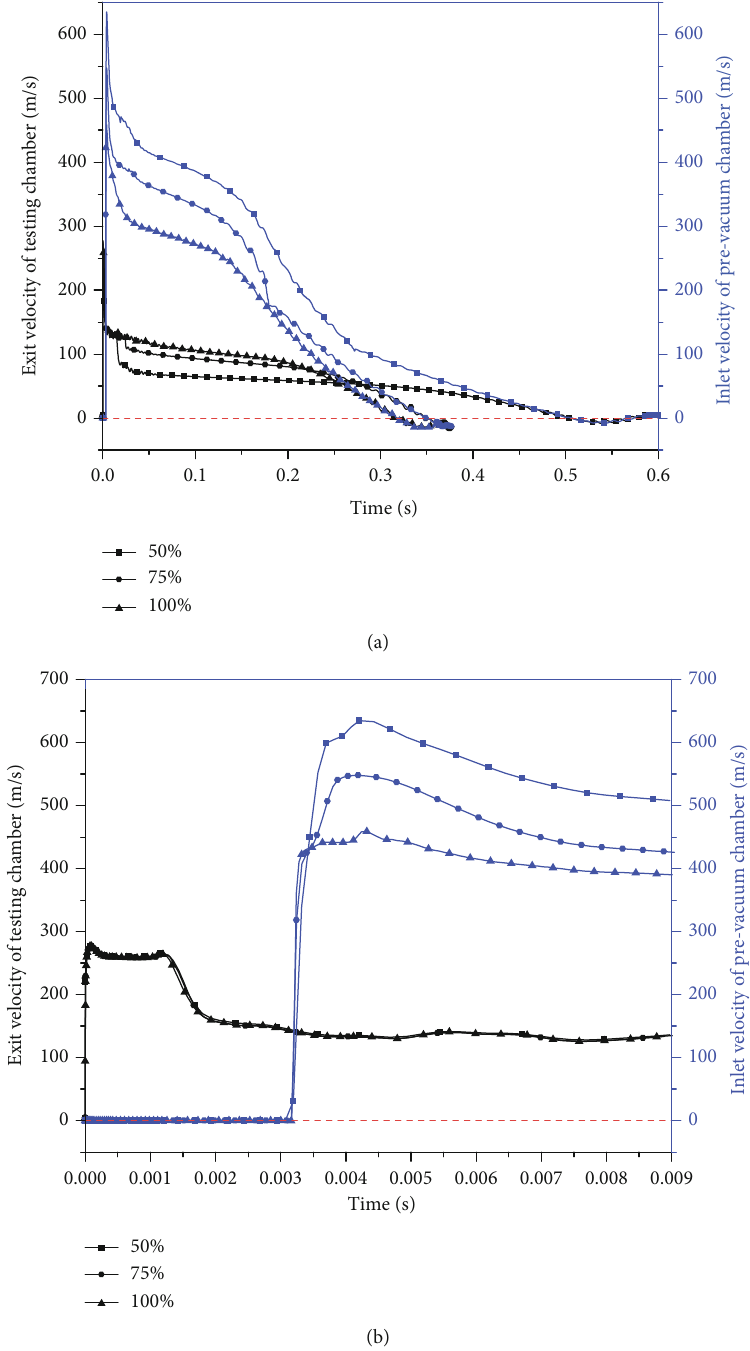
Figure 6: The change of average velocity under di ff erent